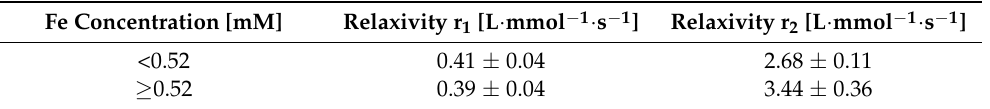
Figure 6. ( A ) Relaxation rate R 1 and ( B ) relaxation rate R 2 as functions of real iron concentrations in AuBSA-Fe samples, as determined by ICP-MS (values are listed in Table S7). Table 2. The values of r 1 and r 2 relaxivities assessed for AuBSA-Fe samples, depending on real iron concentrations, as determined by ICP-MS. Two linear regimes are recognized by a jump around the value of 0.52 mM in Fe